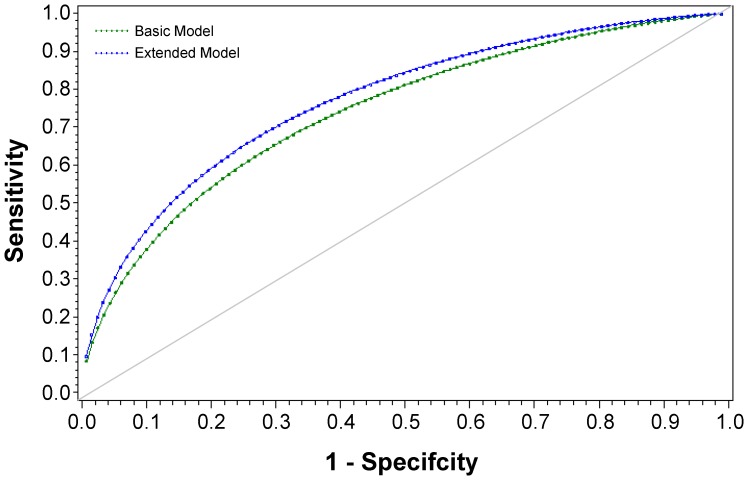
Receiver-Operating Characteristic (ROC) Curve for “Basic” and “Extended” Models for 29 Month Risk of Cardiovascular Disease (CVD) in SMART.The “basic” model included the following baseline covariates: age, gender, race, ART use, plasma HIV RNA level, CD4+ cell count, prior AIDS diagnosis, smoking, BMI, prior CVD, diabetes, hypertension treatment, hyperlipidemia treatment, total/HDL cholesterol, presence of major ECG abnormalities, hepatitis B or C co-infection and treatment group. The “extended” model includes these covariates plus hsCRP, IL-6 and D-dimer after log10 transformation.